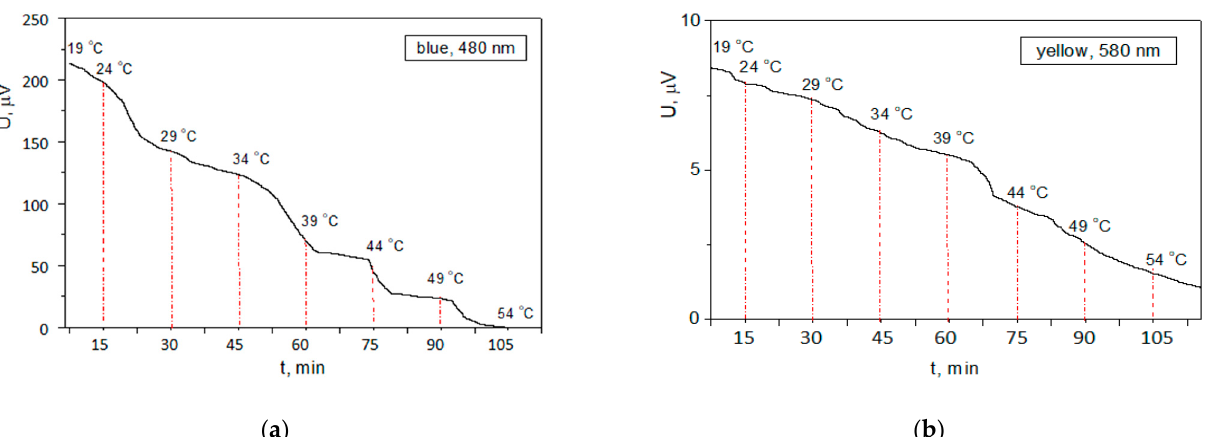
Figure 9. Stability of the photovoltage against temperature at a constant illumination: ( a ) for the iodine-based perovskite solar cell; ( b ) for the chlorine-based perovskite solar cell.